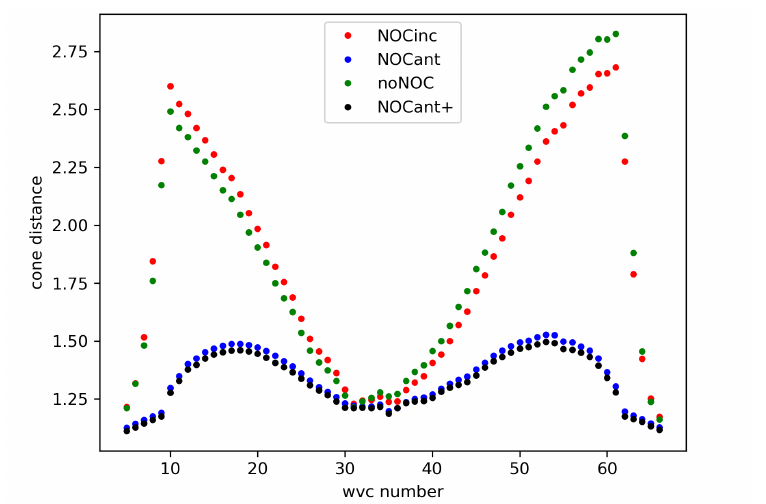
Figure 14. Average MLE (cone distance) as a function of WVC for C-band ascending orbits (noNOC is green, NOCinc is red, NOCant is blue, NOCant+ is